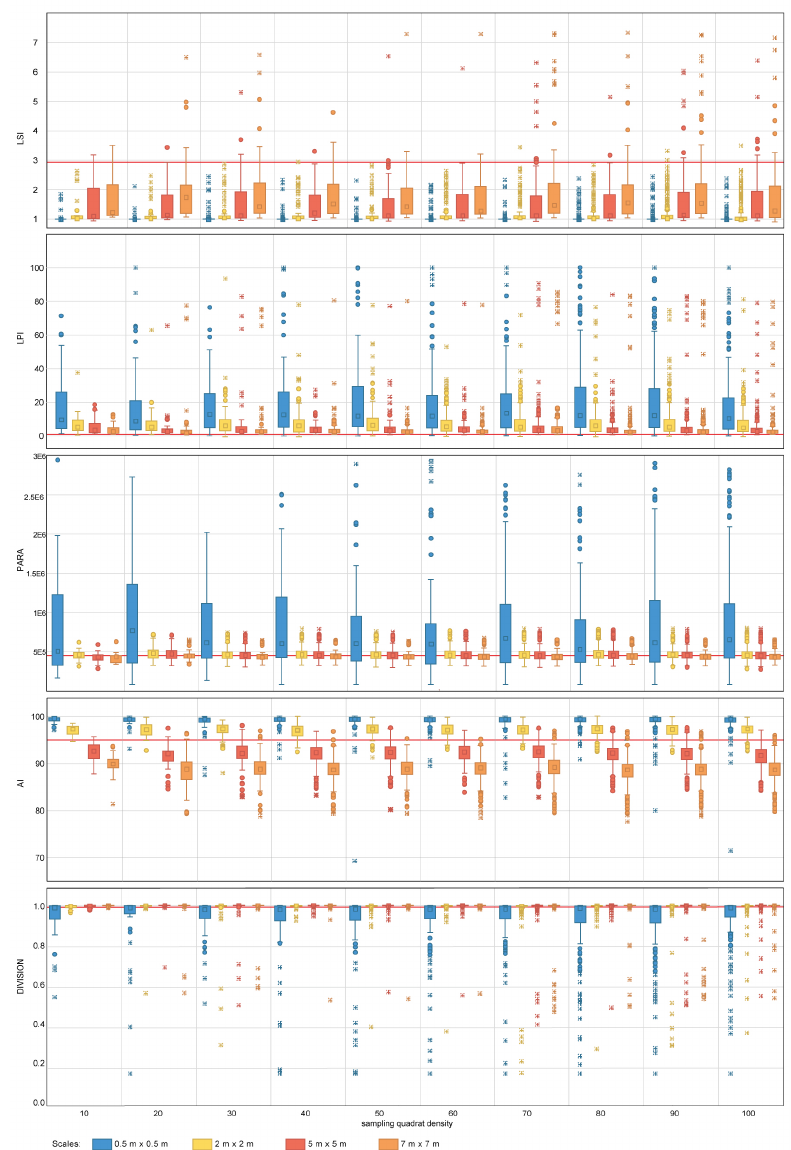
Figure 6. Area-density-edge, shape, contagion and interspersion metric values obtained for the nested sampling strategy for the range of scales and quadrat densities considered. The red horizontal line indicates the metric value obtained on the total area mapped. LSI, LPI, PARA, AI and DIVISION stand for Landscape Shape Index, Largest Patch Index, Perimeter Area Ration Mean, Aggregation Index and Division Index, respectively. The boxplots show the first, second (median), third and fourth quartiles. Circles and crosses indicate outliers and extreme values,